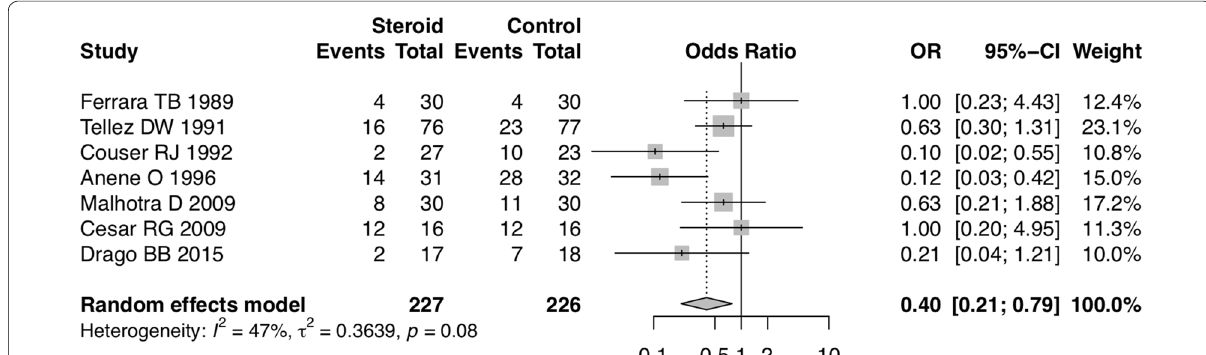
Fig. 3 Result of meta-analysis for effects of corticosteroids on incidence of stridor/suspected upper airway obstruction in randomized controlled trials. An odds ratio (OR) less than 1 favors corticosteroid administration